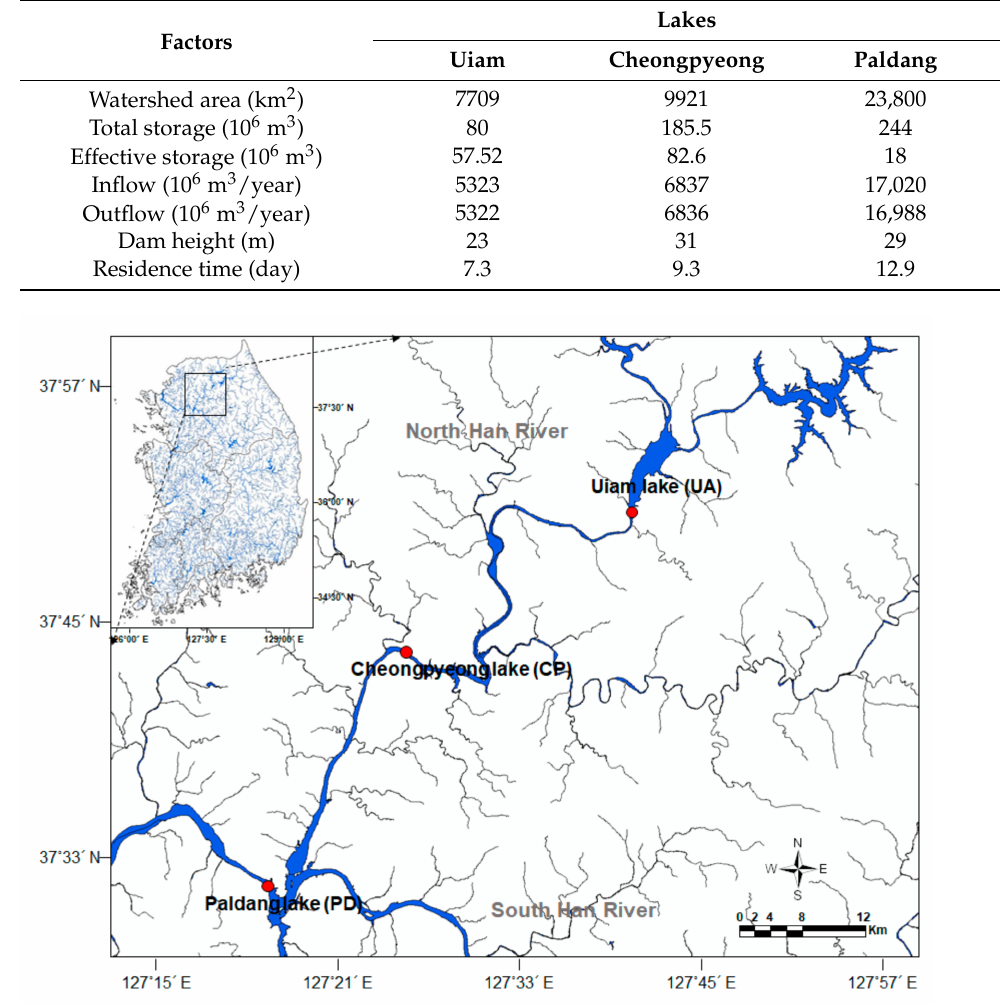
Table 1. Information of morphometric and hydrological characteristics in three lakes in the study.